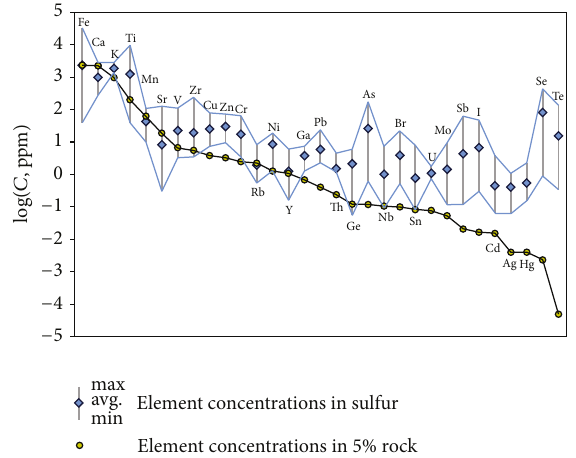
Figure 8: Elemental concentrations in sulfur compared to their corresponding concentrations in “5% rock” (Ebeko andesites). The “5% rock” approximates the contribution of rock particles to the composition of fumarolic incrustations. For each element, its minimum, maximum, and average concentrations are shown. Elements are arranged from high to low concentrations in rock (Ebeko andesite). The distance in log units on the plot between a point showing the concentration of an element in sulfur and a point showing the concentration of the same element in “5% rock” corresponds to the “enrichment factor” for this element.